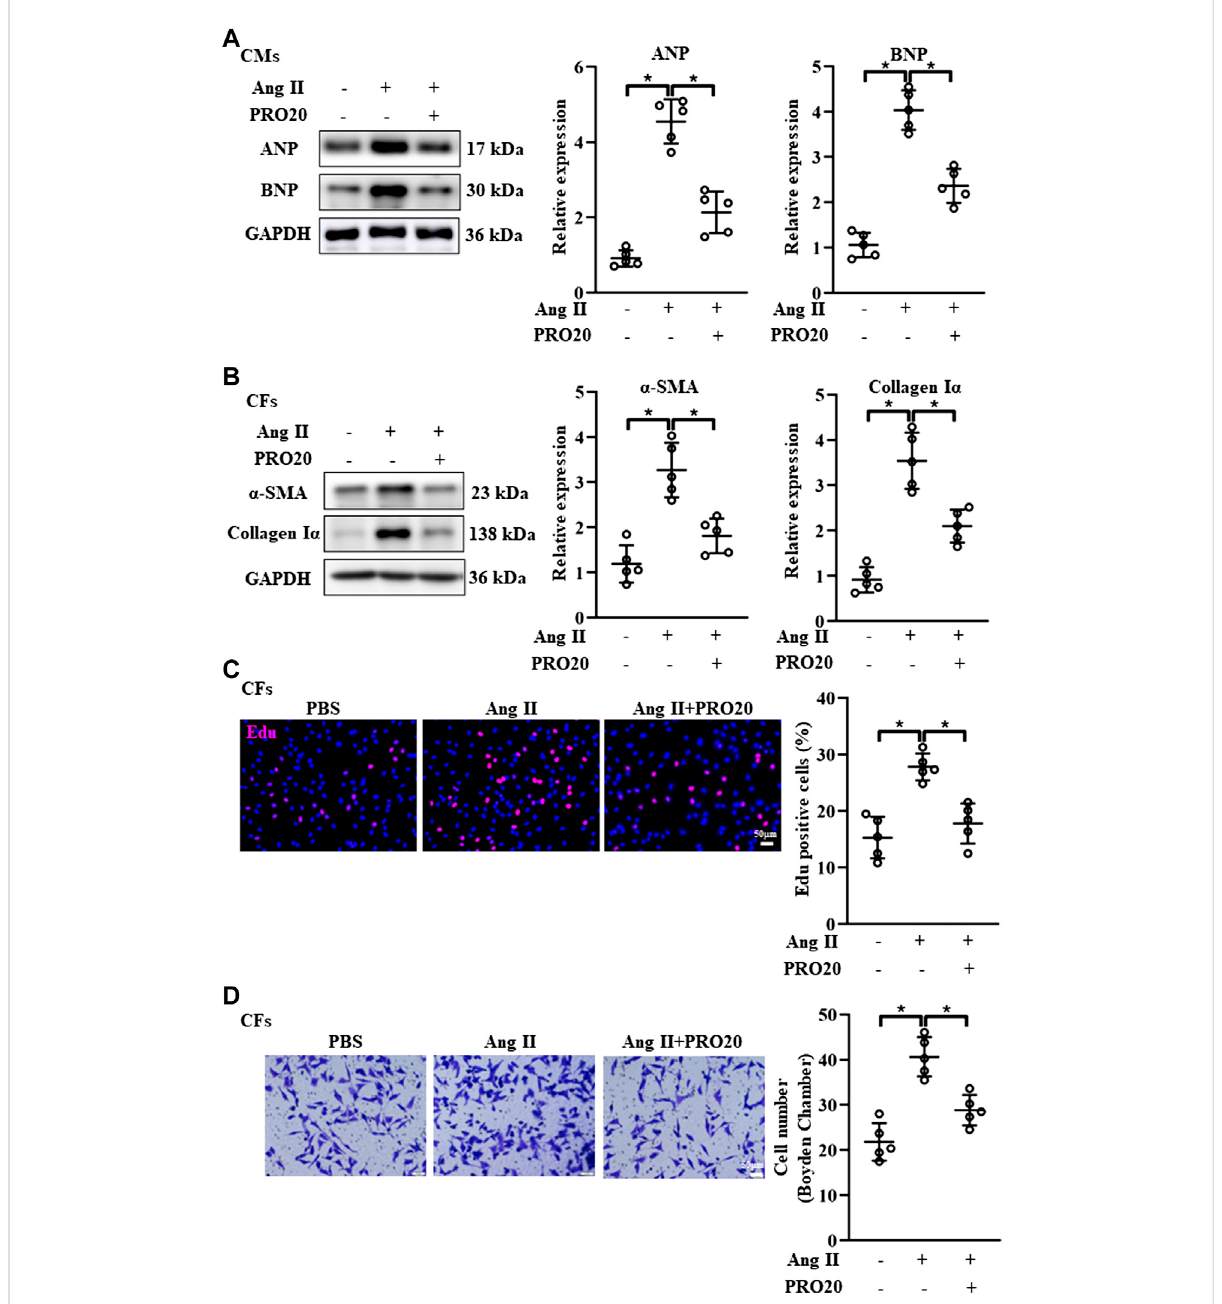
FIGURE 4 Inhibition of PRR by PRO20 alleviates CM hypertrophy and CF activation. (A) Immunoblot analysis of ANP and BNP in Ang II-induced CMs and quantitative analysis of the ANP and BNP protein level normalized to GAPDH. (B) Immunoblot analysis of α -SMA and Collagen I α in Ang II-induced CFs and quantitative analysis of the α -SMA and Collagen I α protein level normalized to GAPDH. (C) Effect of PRO20 on CF proliferation assessed by Edu assay. (D) Boyden chamber assay was performed to evaluate the migration of CFs with and without PRO20 treatment (10 nM) in the presence of Ang II. p p -value < 0.05. n = 5 per group. Data are expressed as mean ±